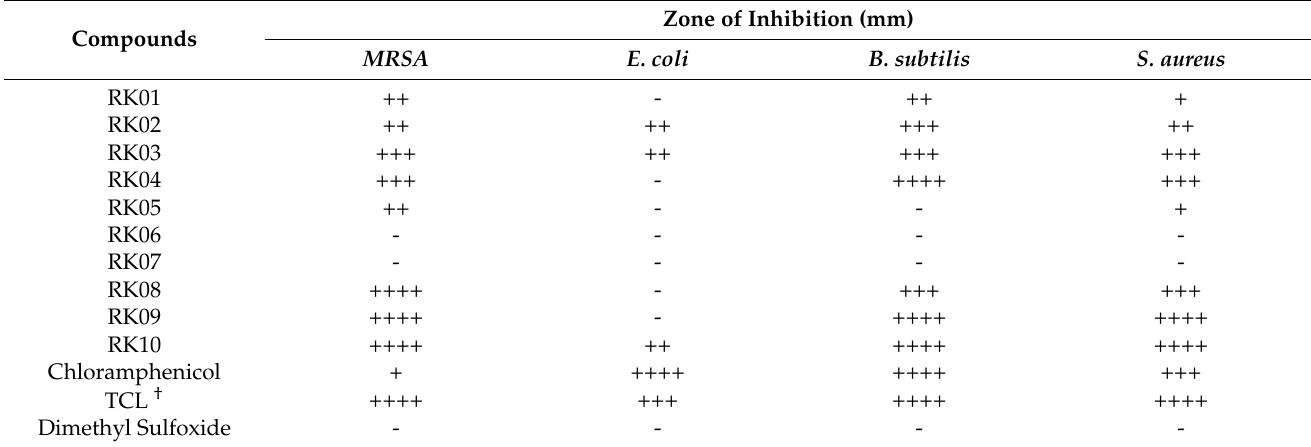
Table 1. The antimicrobial activity of ten compounds tested against MRSA , E. coli , B. subtilis and S. aureus using the disk diffusion